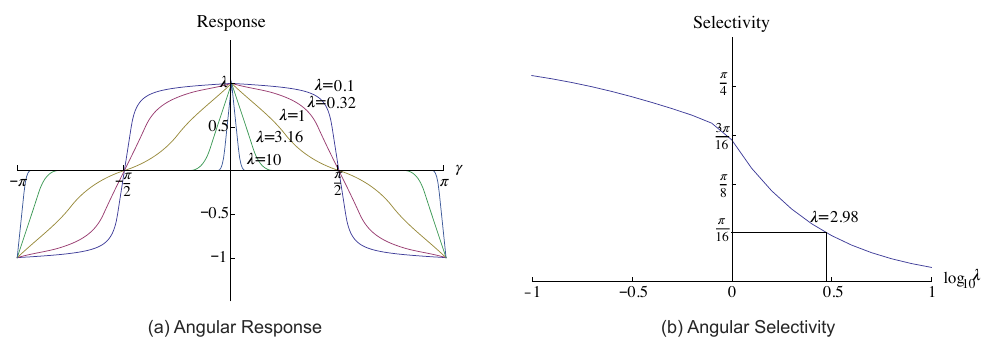
Figure 5. Angular response of DoB for different aspect ratio λ